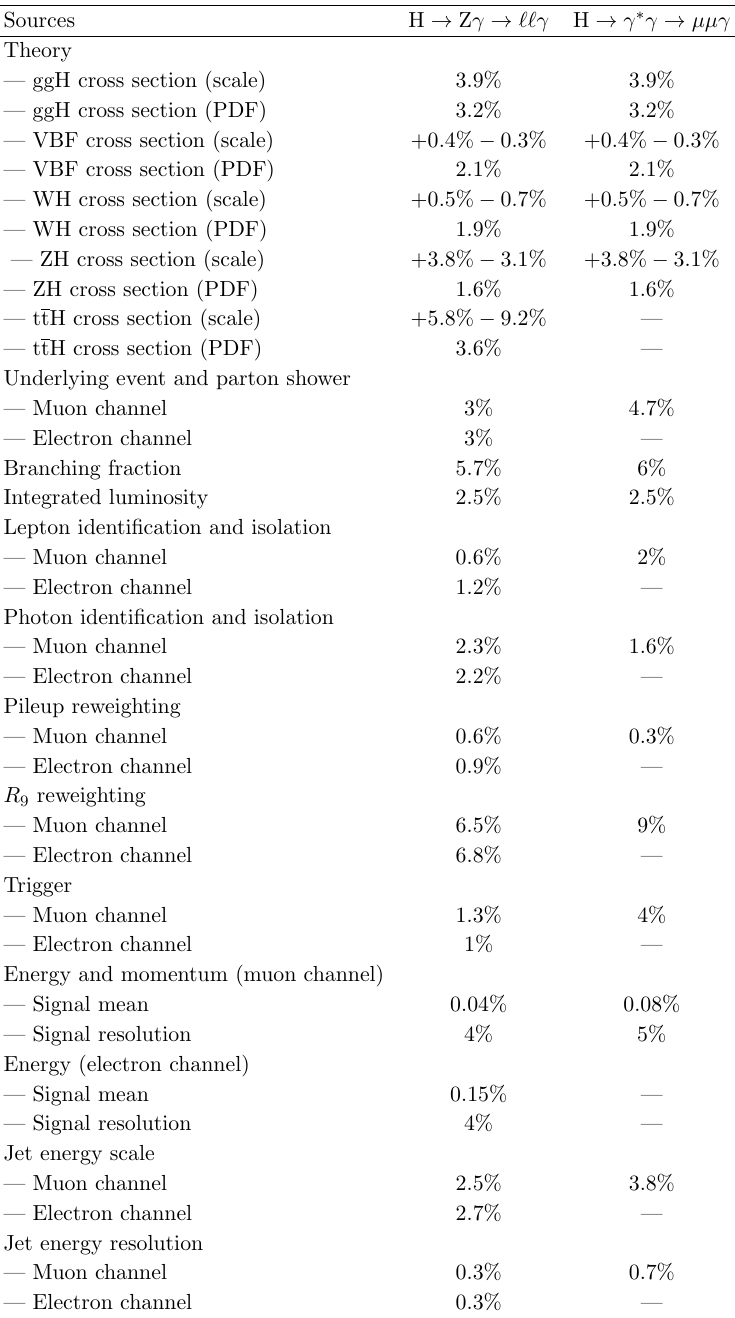
Table 4 . Sources of systematic uncertainties considered in the H analyses. The pre-(cid:12)t values of the nuisance parameters are shown averaged over all the categories in the analysis which either a(cid:11)ect the normalization of the simulated signal event yields or the mean and resolution of m ‘‘(cid:13) . The \|" indicates that the uncertainty is not applicable.